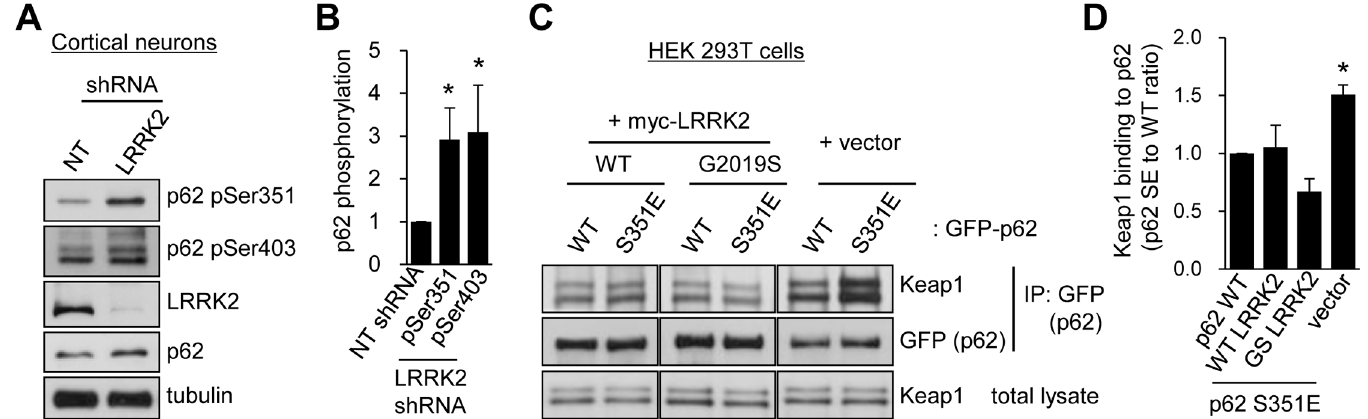
Fig 5. LRRK2 regulates Ser351 phosphorylation of p62. A . Primary cortical neurons were infected with lentivirus that contain LRRK2 shRNA or a non- target shRNA sequence (NT shRNA) for 7 days, and endogenous protein expression levels were analyzed via western blotting with the indicated antibodies. B . Relative phosphorylation levels of p62 after LRRK2 knockdown normalized to NT shRNA were quantified. Summary data are presented as means ± SEM from three independent experiments (NT shRNA, 1.00 ± 0.00; pSer351, 2.92 ± 0.74; pSer403, 3.10 ± 1.09; n = 3; * p < 0.05, paired t -test). C . GFP-p62 WT or Ser351Glu (S351E) was co-transfected with vector control, WT, or G2019S myc-LRRK2 in HEK 293T cells. Endogenous Keap1 bindings to p62 were analyzed via immunoprecipitation with anti-GFP (p62) antibody. D . Quantification data from panel C represent means of relative Keap1 binding to p62 ± SEM (WT LRRK2, 1.05 ± 0.19; GS LRRK2, 0.67 ± 0.11; vector, 1.51 ± 0.08; n = 3; * p < 0.05, paired t